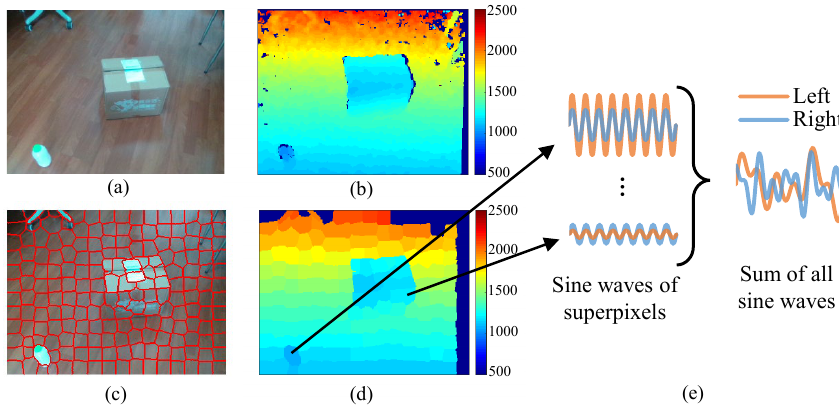
Figure 3. Image sonification. ( a ) Raw color image. ( b ) Raw depth image, where invalid depth values are indicated by dark blue. ( c ) The result of superpixel segmentation on color image. ( d ) Downsampled depth image guided by superpixels in ( c ). ( e ) Schematic of image sonification.